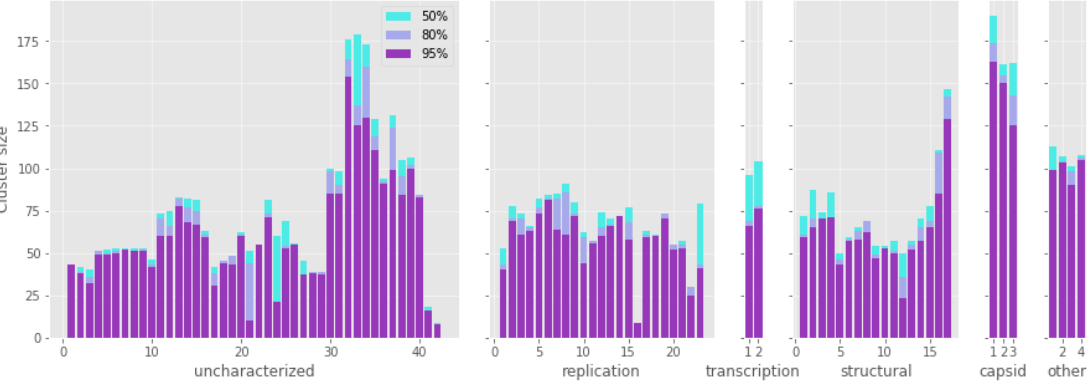
Figure 1. Number of sequences in each group of protein homologs (cluster size) according to functional categories. The three color bars refer to the different similarity thresholds applied to filter alignments (50%, 80%, and 95% respectively). The capsid proteins are the most frequently present in the crAss-like contigs. See Table S2 for the names of all homologous groups of proteins and values for all statistics.